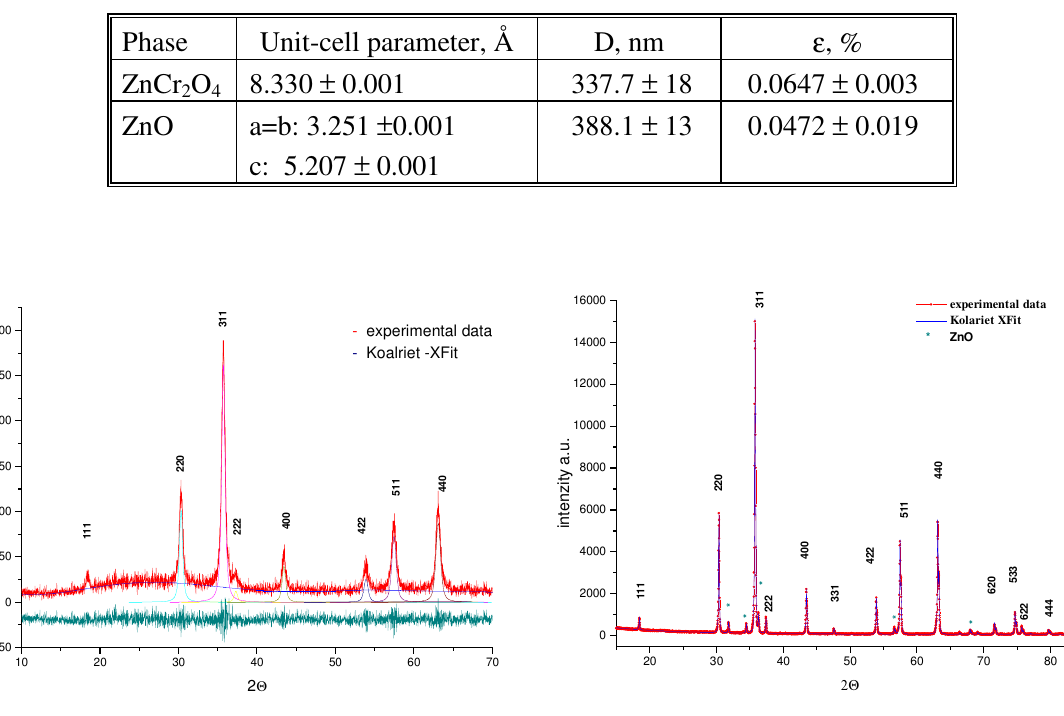
Fig. 2 Experimental and calculated diffraction profiles obtained for as-prepared (a) and